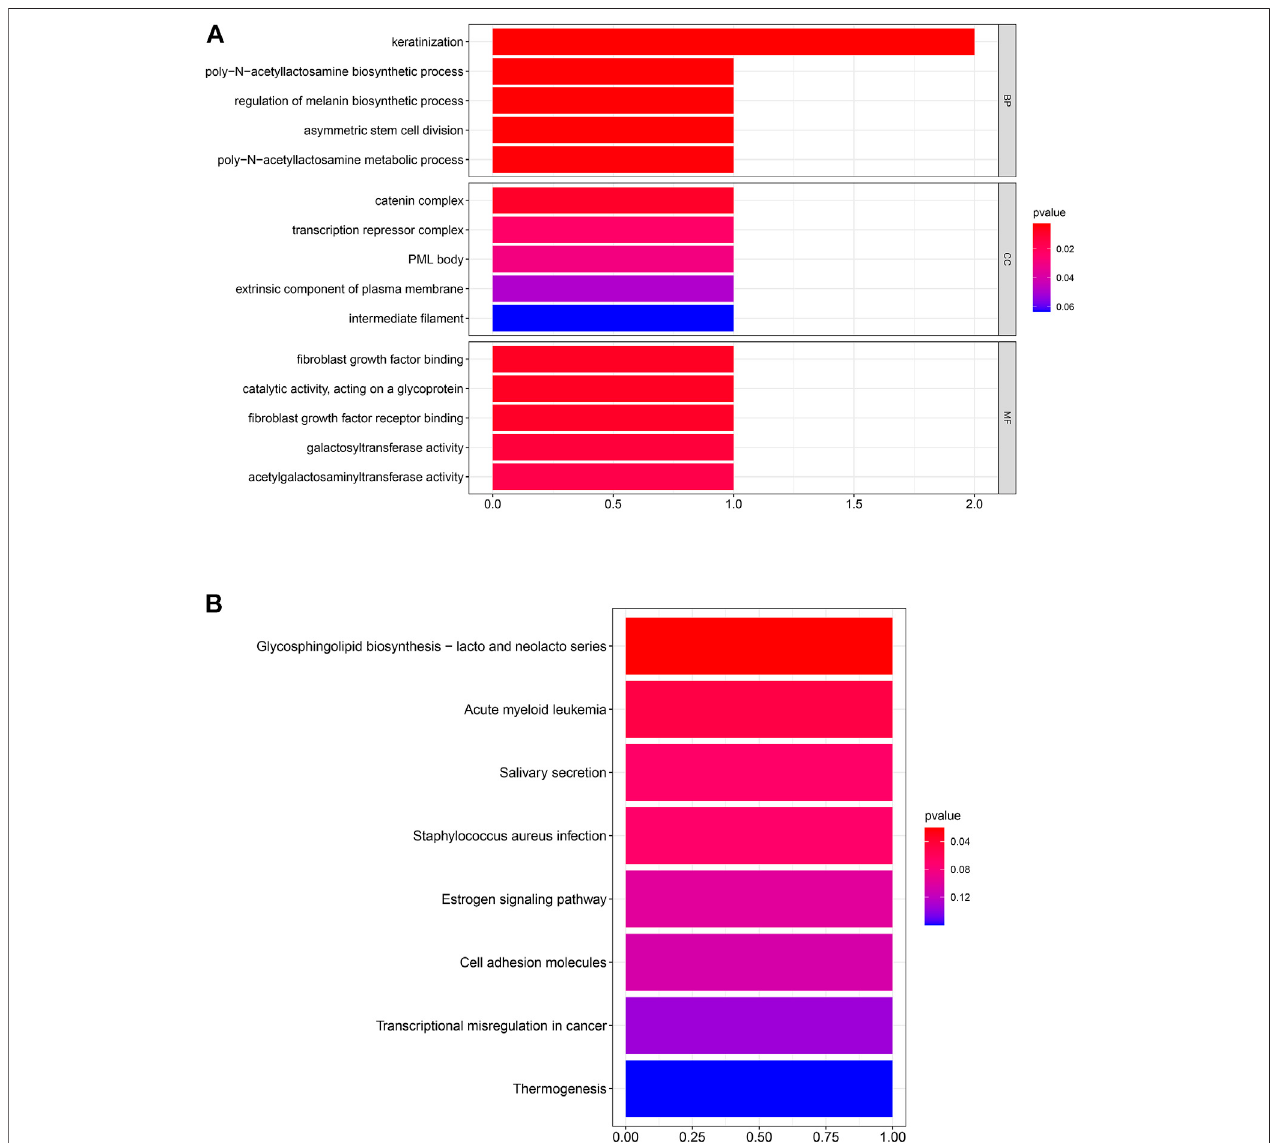
FIGURE 3 | Six hub genes were analyzed for enrichment. The size of the spots represents the gene number, and the color represents the adjusted p -values (BH). (A) Result of GO enrichment analysis. (B) Result of KEGG enrichment analysis.